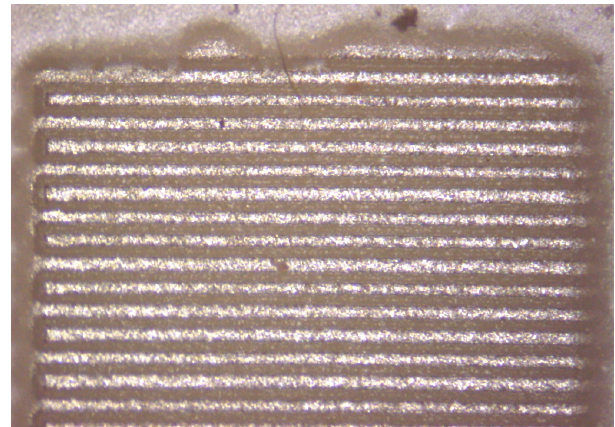
Figure 2. Used IDE structure consisting of a ceramic substrate (Al 2 O 3 ) and platinum interdigital electrodes. The electrode width and distance is 27.5µm, the length 1400µm and the number of legs 34 (Weiss et al.,